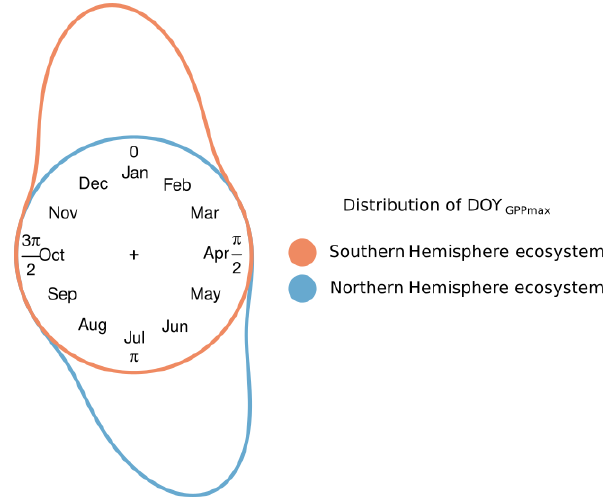
Figure 1. Conceptual distribution of GPPmax timing (DOY GPPmax ) for two hypothetical ecosystems: one in the Northern (blue) and one in the Southern Hemisphere (red). The dis- tance between the color line and the circle represents the frequency of the DOY GPPmax observations. The distance between the end and the beginning of the distribution represents the DOY GPPmax interannual